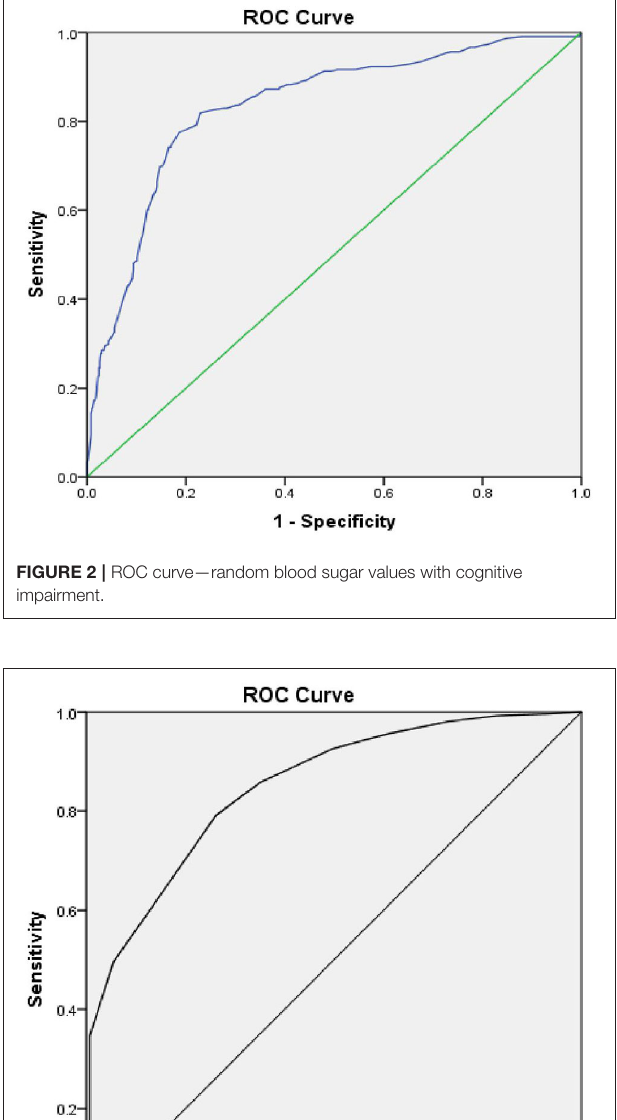
without diabetes who have higher average glucose levels also have a significant risk for dementia (29). The adjusted hazard ratio for dementia in people with a minimally increased glucose level of 6.4 mmol/L (115 mg/dl) was 1.18 (1.04–1.33), suggesting that elevated serum glucose level may be an independent risk factor for cognitive dysfunction (29). Hyperglycemia-mediated advanced glycosylated end product production and